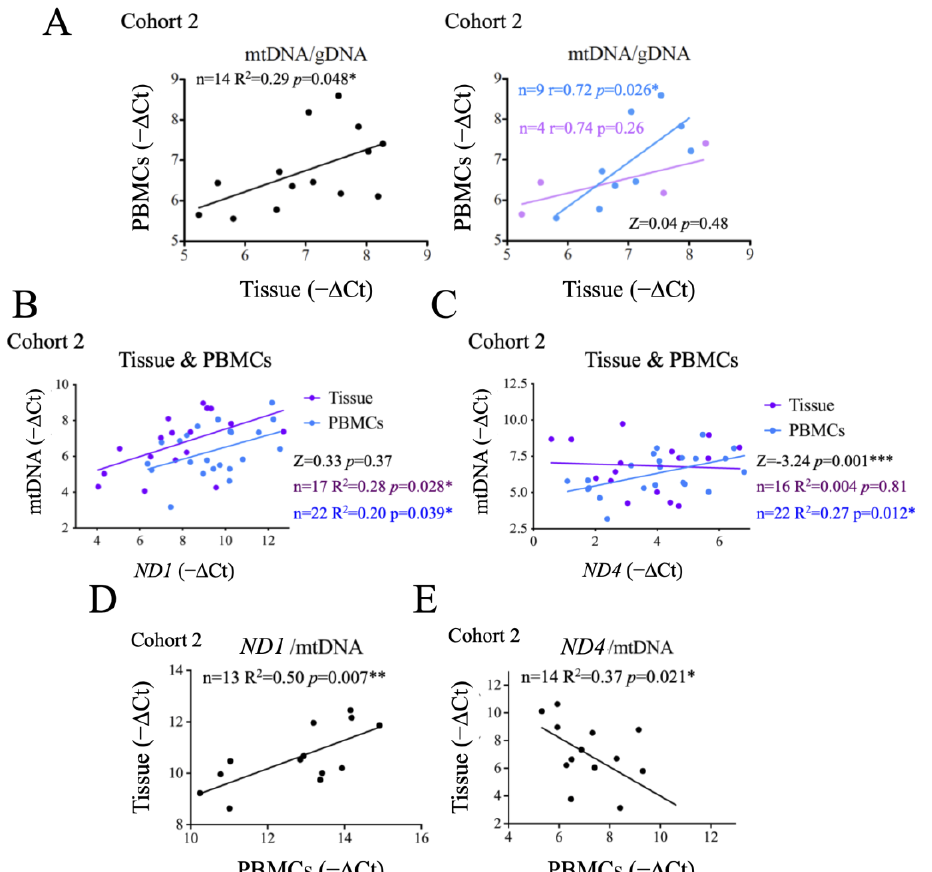
Figure 5. Comparison of mtDNA in thyroid tissue and PBMCs reveals a positive correlation for ND1 but not for ND4 . ( A ) Correlation and linear regression analysis of mtDNA in thyroid tissue vs. PBMCs. ( B ) Correlation and linear regression analysis of mtDNA vs. the presence of the mitochondrial gene ND1 , in thyroid tissue and PBMCs. ( C ) Correlation and linear regression analysis of mtDNA vs. the presence of the mitochondrial gene ND4 , in thyroid tissue and PBMCs. ( D ) Correlation analysis of ND1 /mtDNA ratios in thyroid tissue vs. PBMCs. E) Correlation and linear regression analysis of ND4 /mtDNA in tissue vs. PBMCs. *, p < 0.05; **, p ≤ 0.01; ***, p ≤ 0.005.